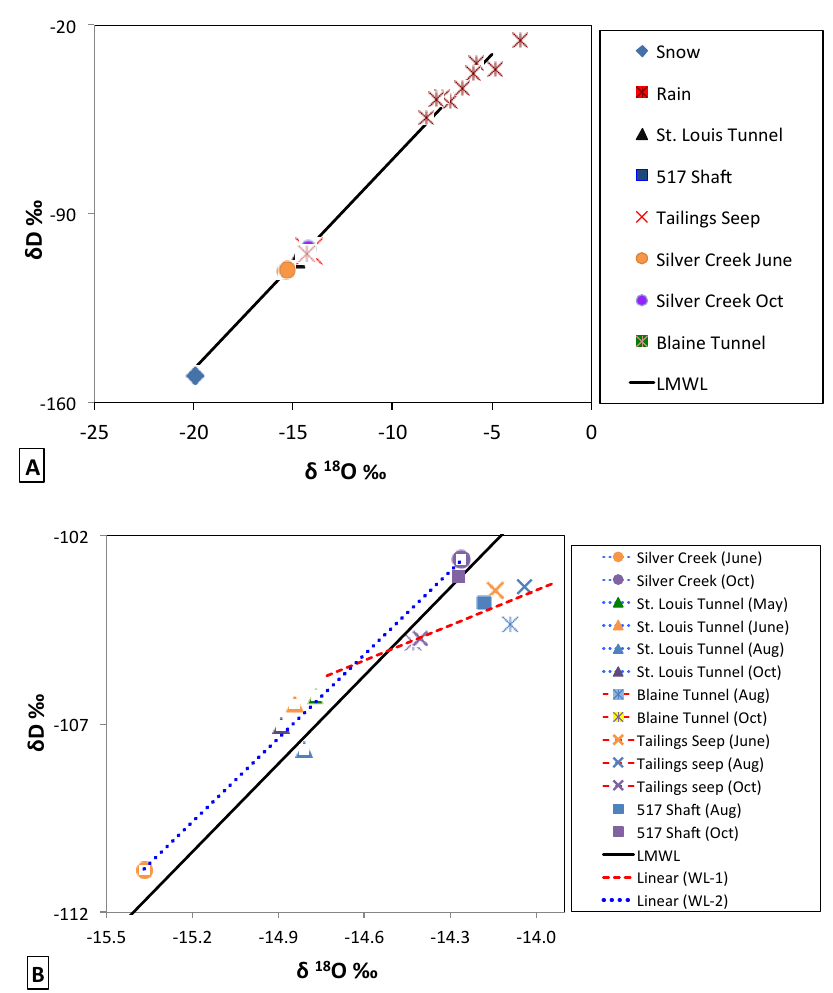
Figure 5. ( A ) Plot of δ 18O vs. δ D for precipitation, surface waters, and mine waters. The St. Louis Tunnel, 517 shaft, Blaine tunnel, Tailings seep, and Silver Creek are the arithmetic mean from all samples collected. The Local Meteoric Water Line (LMWL) is plotted in black; ( B ) Seasonal variations of δ 18O vs. δ D for surface waters and mine waters in 2011. The LMWL is plotted with a second water line (WL1; red dash), representing samples from the Tailings seep and the Blaine Tunnel and a third water line (WL2; blue dot) representing samples from Silver Creek and the St. Louis Tunnel. The symbol shapes correspond to similar sites in (A) and (B), while colors represent similar dates for different sites in